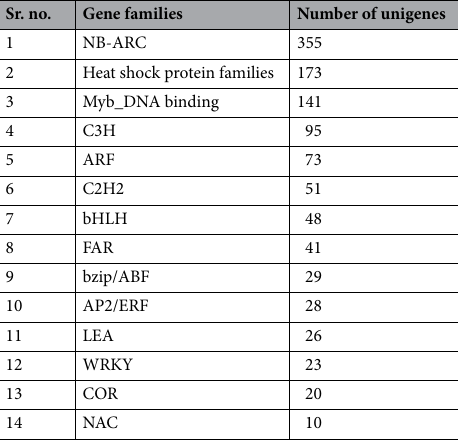
Table 5. Representative gene families related to stress resistance in faba bean.